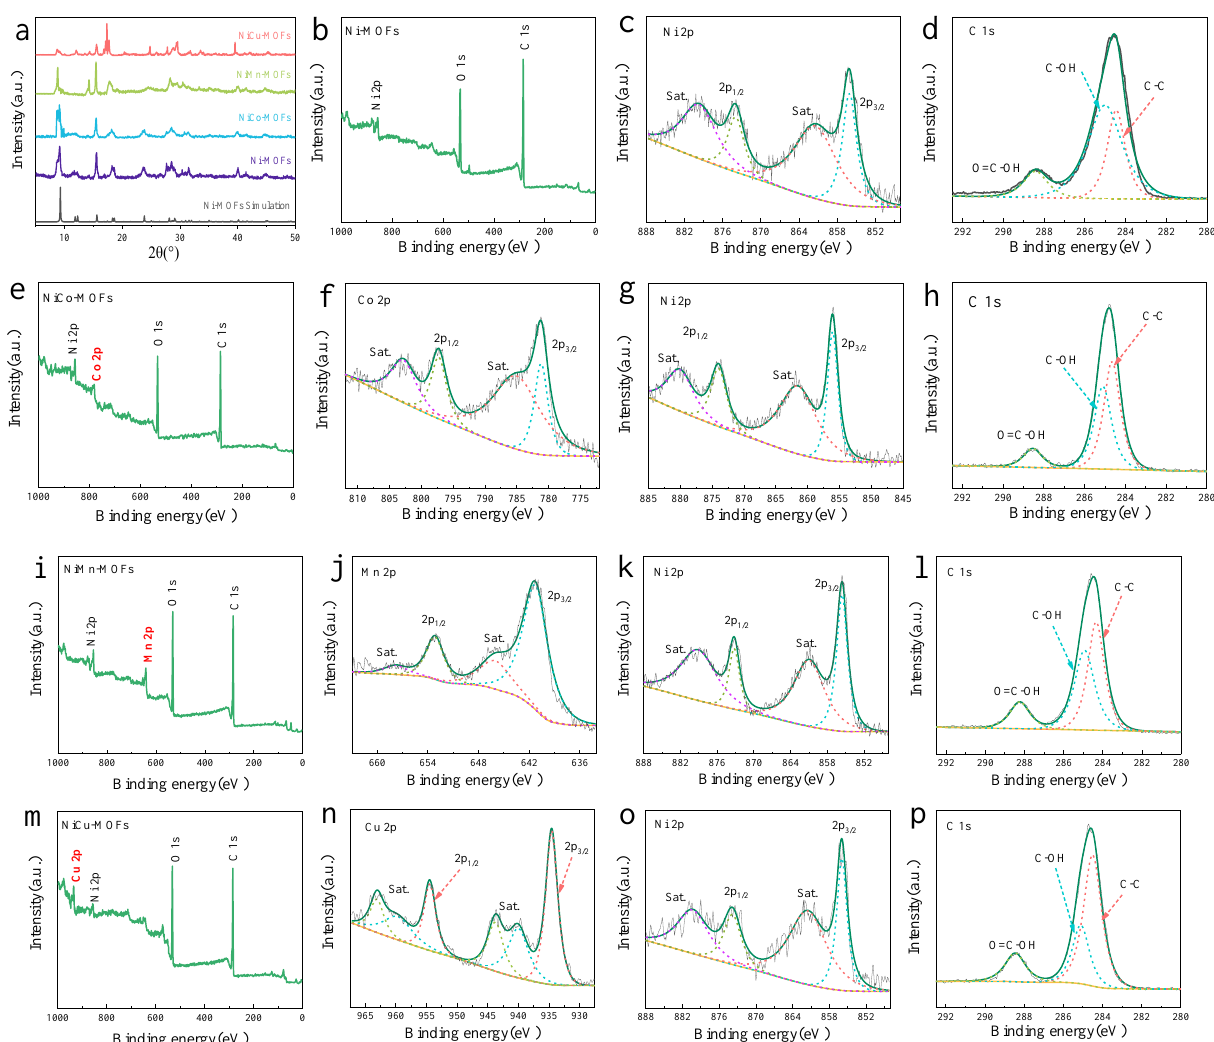
Figure 1. ( a ) XRD patterns of Ni-MOFs, NiCo-MOFs, NiMn-MOFs, and NiCu-MOFs; XPS spectra of ( b – d ) Ni-MOFs, ( e – h ) NiCo-MOFs, ( i – l ) NiMn-MOFs, and ( m – p ) NiCu-MOFs.